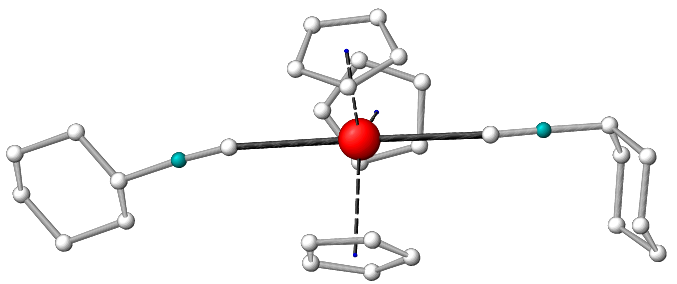
Figure 3. View to the molecular structure of (Cp) 3 La(C ≡ NCy) 2 in the solid state; presented is the isomer with one equatorial (on the left) and one axial (on the right) C ≡ NCy conformer. C atom in grey, metal in red, N in blue green and H atoms omitted for reasons of clarity.